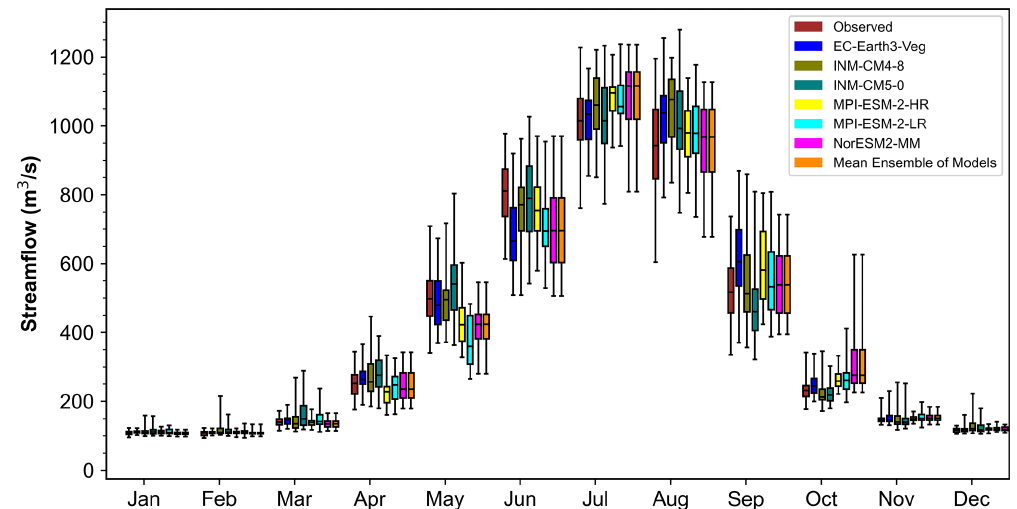
Figure 9. Box plot comparing observed and CMIP6-GCM-simulated (mean ensemble of models) streamflow for various months of the year, as derived over the period 1979–2009. The line inside the box denotes the median values of the streamflow, while the upper and lower whiskers indicate the highest and minimum values,